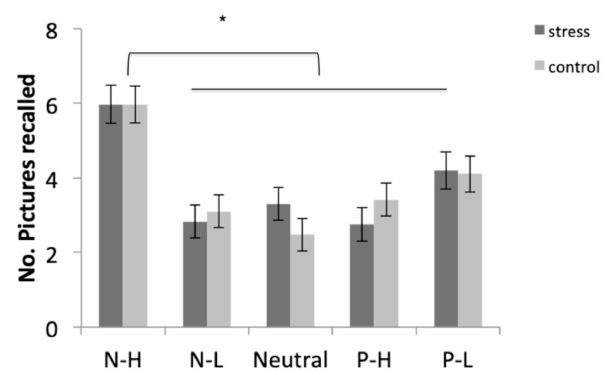
Figure 4. Free recall performance for negative-high (N-H), negative-low (N-L), neutral, positive-high (P-H), and positive-low (P-L) pictures in the stress and control conditions. Error bars represent standard error of mean (S.E.M.) (* p < 0.001).